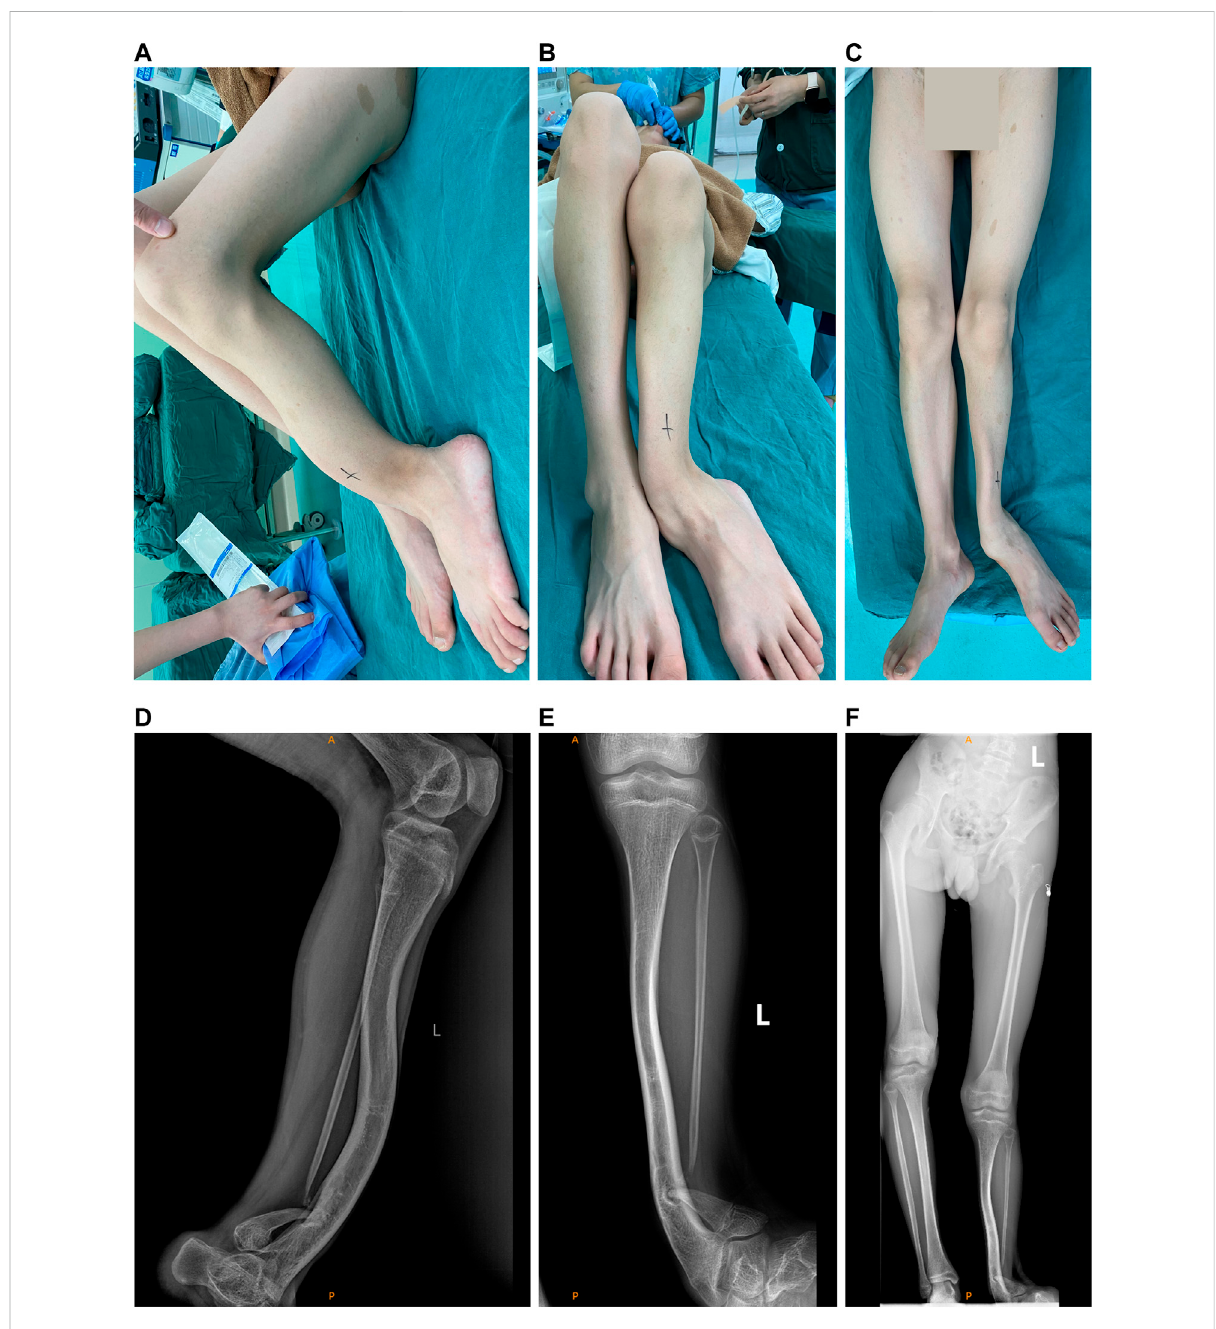
FIGURE 1 Appearance photos and X-ray images of the left limb of the proband. (A) Lateral photo of the pseudarthrosis of left tibia. (B) Photo of pseudarthrosis of the left tibia and the left ankle valgus. (C) Photo of the unequal lengths of the left and right limb. (D) X-ray image of the pseudarthrosisoflefttibia. (E) X-rayimageofthepseudarthrosisofthelefttibiaandtheleftanklevalgus. (F) X-rayimageoftheunequallengthsofthe left and right